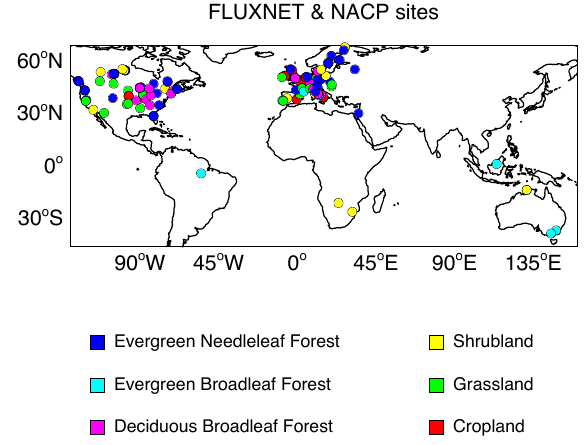
Figure 1. Distribution of 145 sites from the FLUXNET and the North American Carbon Program (NACP) network. The duplicated sites have been removed. The color indicates different plant func- tional types (PFTs) as evergreen needleleaf forest (ENF, blue), ev- ergreen broadleaf forest (EBF, cyan), deciduous broadleaf forest (DBF, magenta), shrubland (SHR, yellow) grassland (GRA, green), and cropland (CRO, red). “mixed forests” are classified as ENF, “permanent wetlands”, “savannas”, and “woody savannas” as SHR. The PFT of each site is described in Table S1 in the